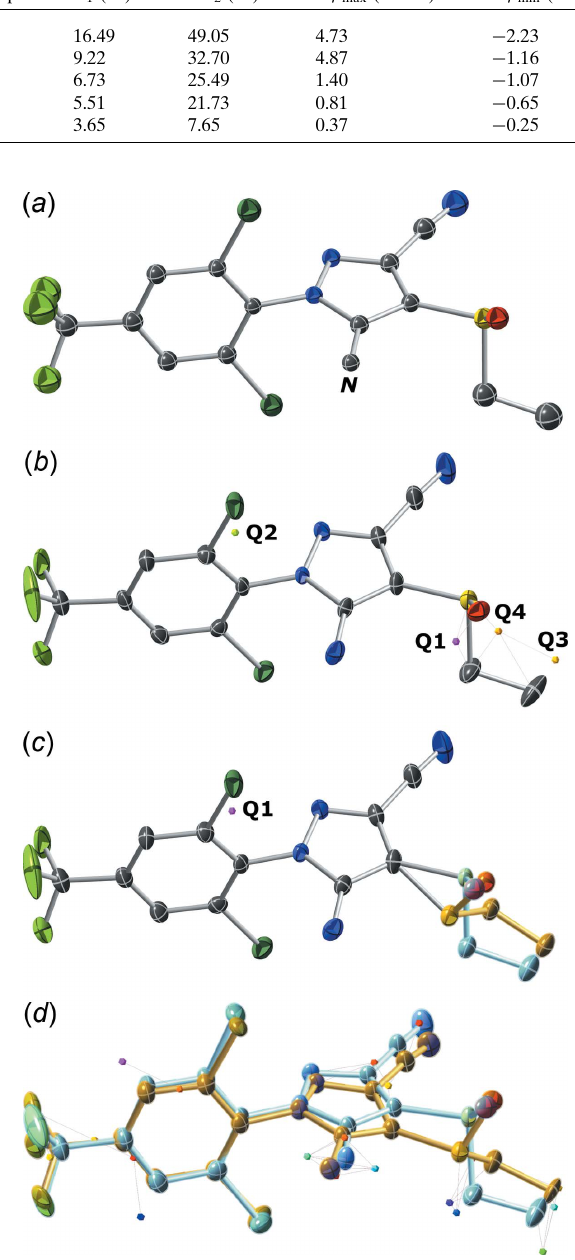
Figure 5 Snapshots of the structure model at various stages of complexity. ( a ) Initial model after structure solution by SHELXT . All atoms except the amine nitrogen (here labelled N ) were assigned correctly. ( b ) After anisotropic refinement, three of the largest difference map peaks (Q1,Q3,Q4) suggest disorder of the ethanesulfinyl group. ( c ) A partial disorder model with the ethanesulfinyl group split over two configura- tions reveals unrealistic distortion at the connection to the pyrazole ring, hinting that the disorder must extend further into the rest of the molecule. ( d ) Modelling of whole-molecule disorder satisfactorily accounts for all spurious electron density, revealing the major-component hydrogen atoms (small coloured